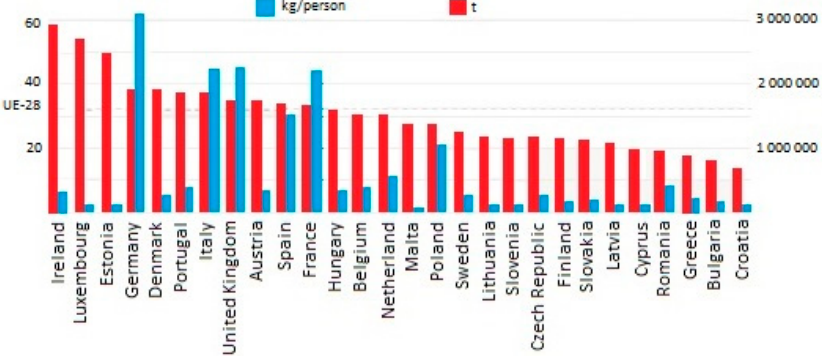
Figure 1. The amount of waste plastic packaging in Europe in 2016 [1,20].